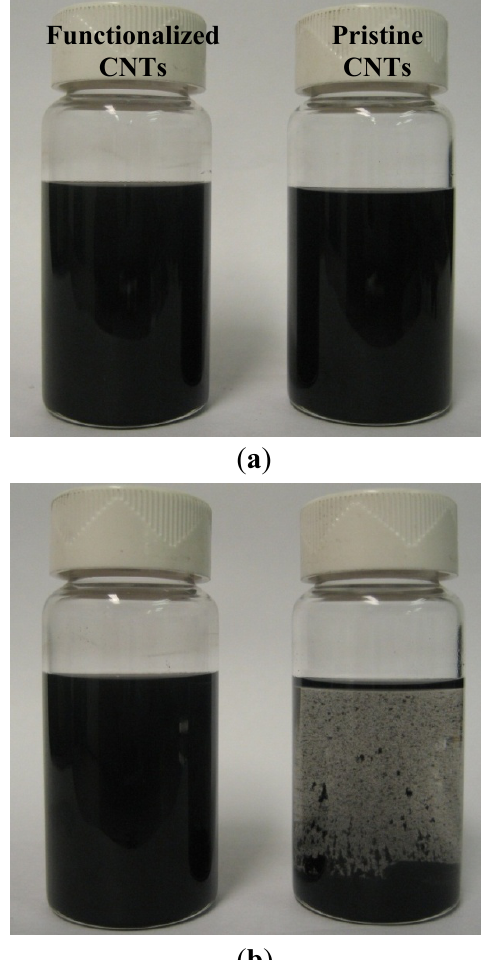
Figure 5. Comparative studies of functionalized and pristine MWCNTs in their dispersion with polymer matrix in common solvent: ( a ) initial dispersion of MWCNTs directly after sonication and stirring showing nontransparent solutions and ( b ) dispersion at 4 h after the stoppage of stirring, with pristine MWCNT case showing clear phase